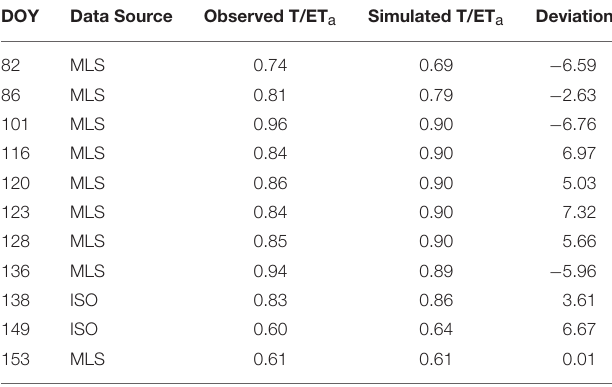
TABLE 8 | Ratio of simulated